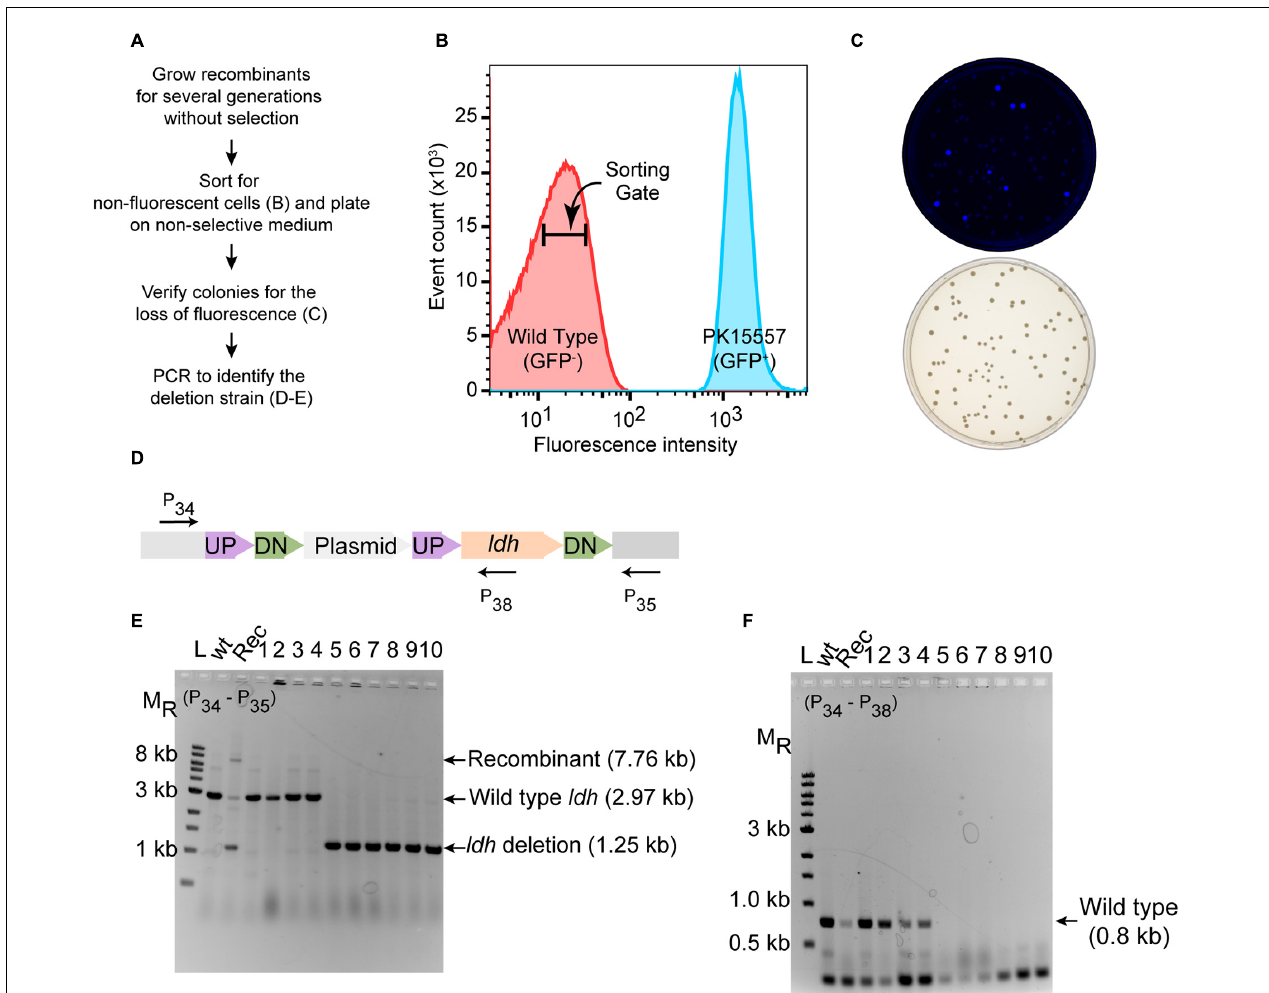
FIGURE 3 | Deletion of ldh gene. (A) Workflow for enrichment of non-fluorescent cells and screening for the modified genome. (B) Plot from FACS of Z. mobilis strain PK15557 that has suicide plasmid (pPK15535) recombined into the genome. The X -axis represents fluorescence intensity and Y -axis represents the total number of sorted events. The sorting gate for collecting the non-fluorescent cells (red peak) is indicated by the bar. (C) Top plate shows the fluorescence image of colonies from FACS sorted non-fluorescent cells plated on non-selective media. Bottom plate shows the same colonies viewed with visible light. (D) The location of primers used to screen non-fluorescent candidates for wild-type (wt) and deletion genotypes by PCR is indicated by arrows. (E,F) Agarose gel electrophoresis of products from PCR amplification of 10 non-fluorescent-candidate colonies. Selected size markers are indicated on the left (M R ). (E) Amplification using primers P34 and P35 yielded a 1.25-kb DNA fragment for the ldh deletion whereas the wt ldh DNA fragment was 2.97 kb. Strains that still possess the plasmid integrated into the genome (Rec) are expected to have a band of 7.8 kb. (F) Amplification using P34 and P38 yielded a DNA fragment of 0.8 kb, confirming those strains that still possess the ldh gene, while strains in which ldh has been deleted (six total) lacked the equivalent amplified fragment. Labels are the same as in panel E . Similar results were obtained when this experiment was biologically replicated three times.